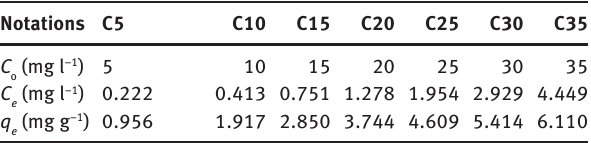
Table 1: The fluoride removal capacities at different initial concen- trations of